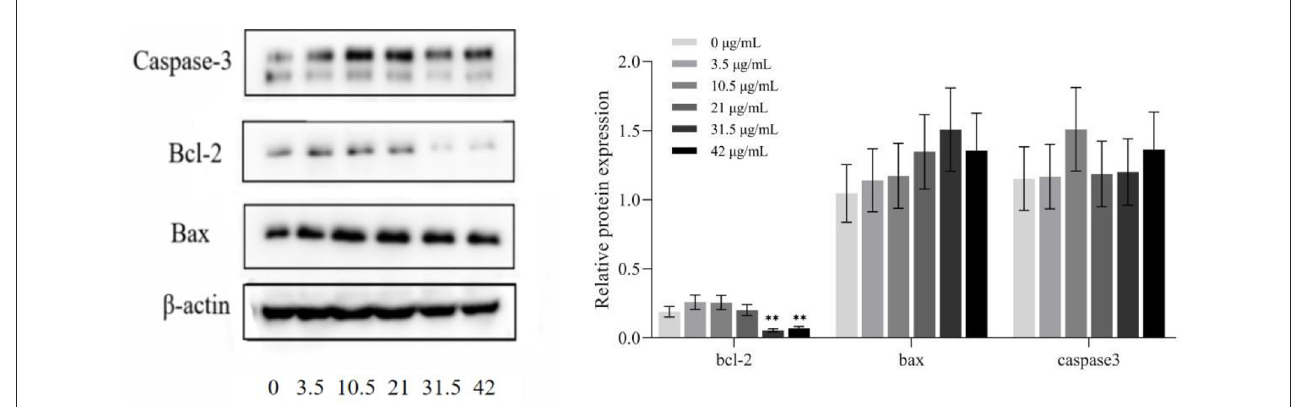
FIGURE7 Protein expression in HepG2 cells treated with different concentrations of TG. * P < 0.05; ** P <